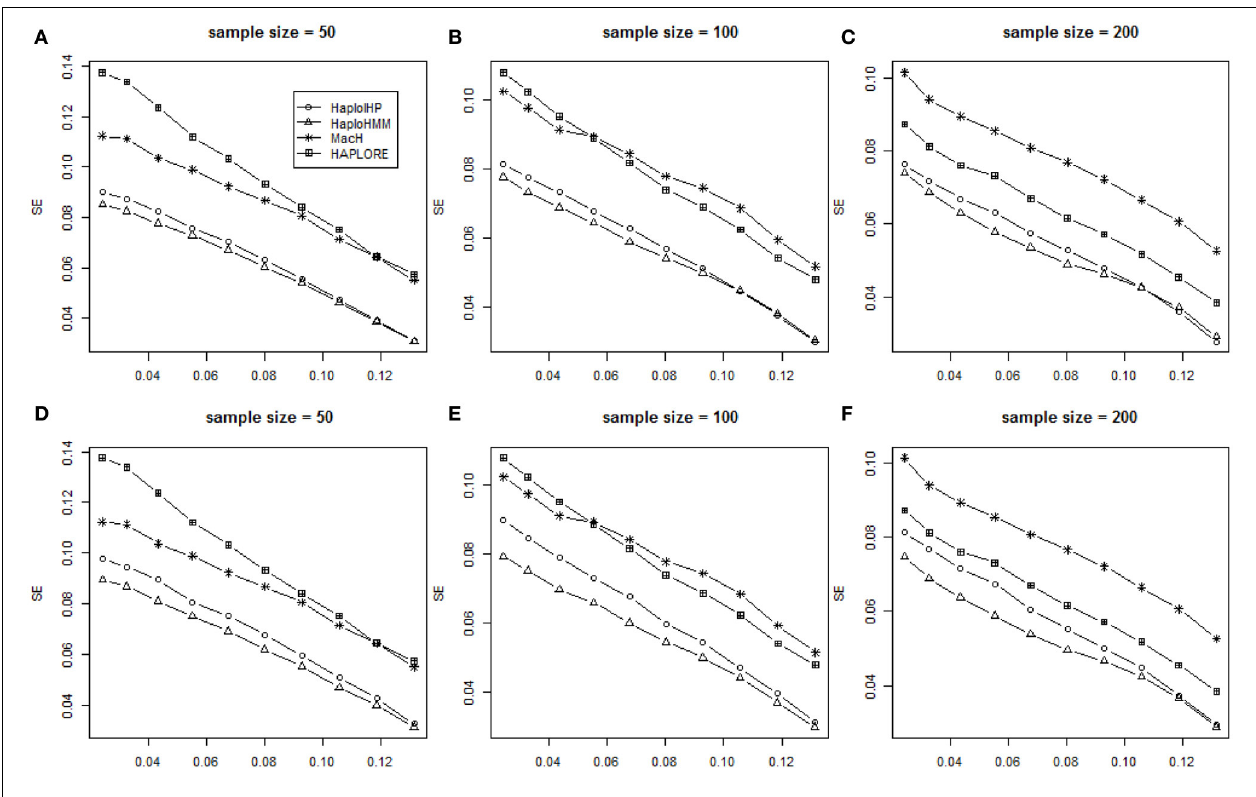
FIGURE 3 | Average values of SE with the sample size of 50, 100, and 200 and the assumption of HWE under different haplotype frequency distributions. The x-axis represents the standard deviation of haplotype frequencies used in simulations.